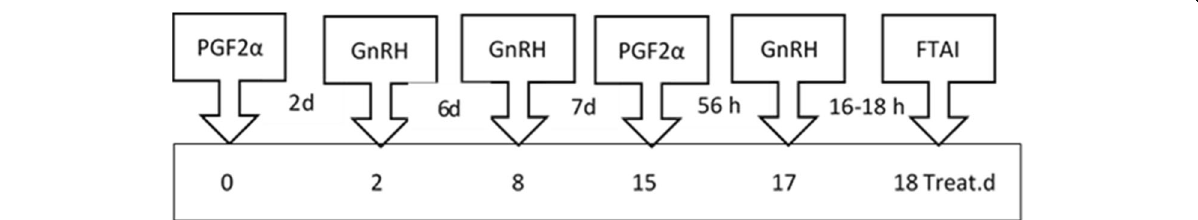
Fig. 2 Schematic representation of the G6G breeding program. (PGF2 α , prostaglandin F2 alpha; GnRH, gonadotropin releasing hormone; FTAI, fixed-time artificial insemination; Treat. d, treatment days)